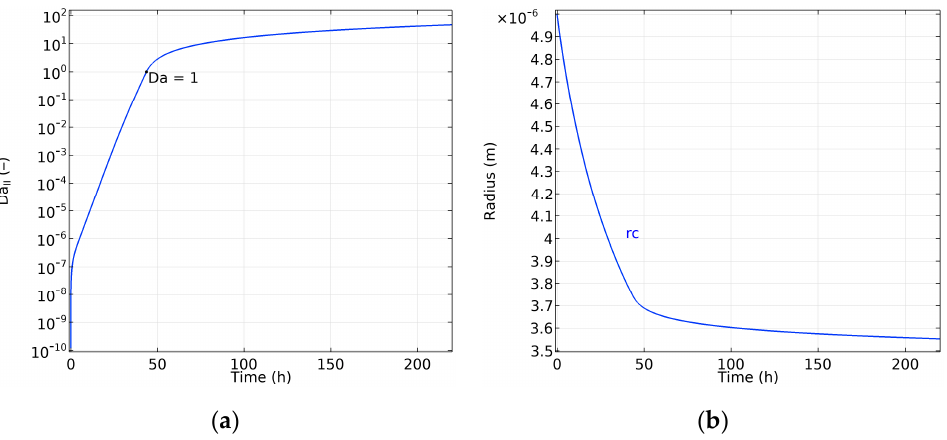
Figure 3. ( a ) Da II for Experiment at HCl 0.1 M and 𝑆/𝐿 5 g/L. ( b ) Radius of the particle and the inner core.